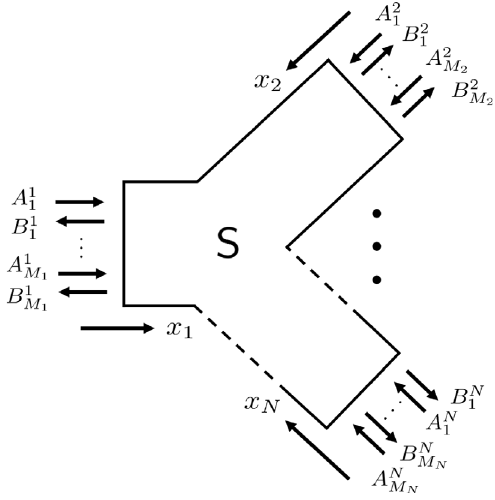
Figure 1. Illustration of an acoustic system S with N